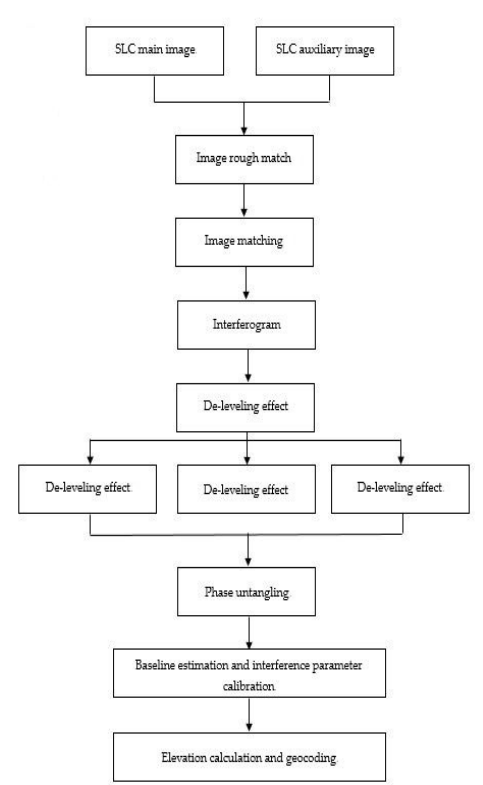
Figure 3. InSAR data processing